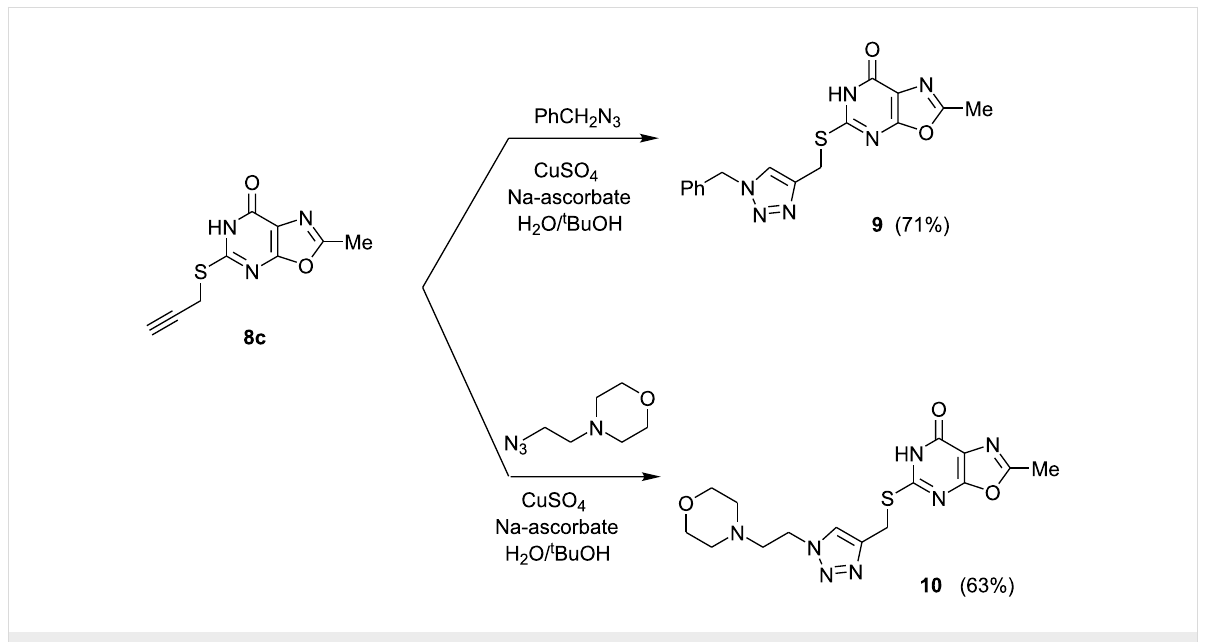
Figure 5: Click chemistry elaboration of a 5-(propargylthio)oxazolo[5,4- d